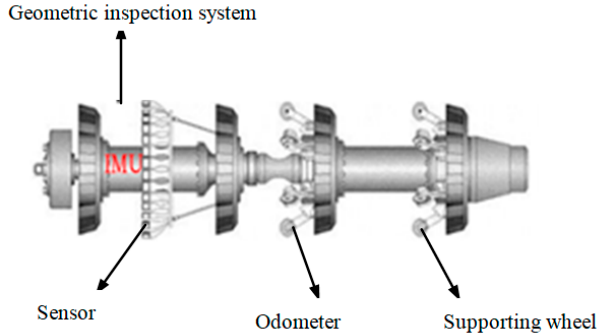
Figure 5. IMU in-line inspection